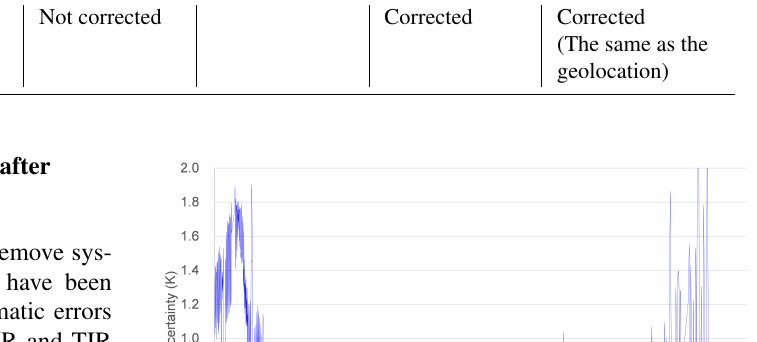
correction table provided from